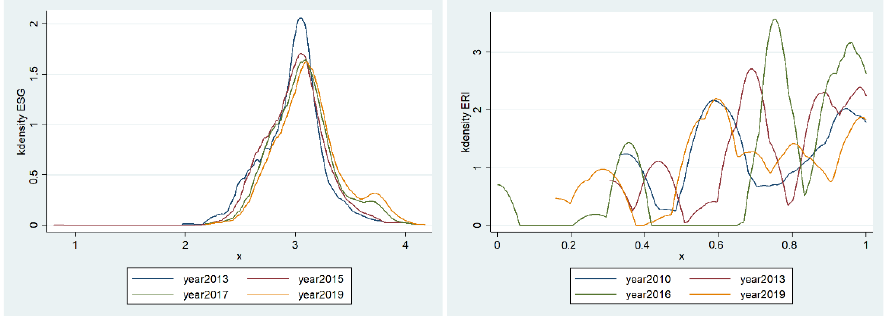
Figure 2. Kernel density chart of ESG performance and ERI .